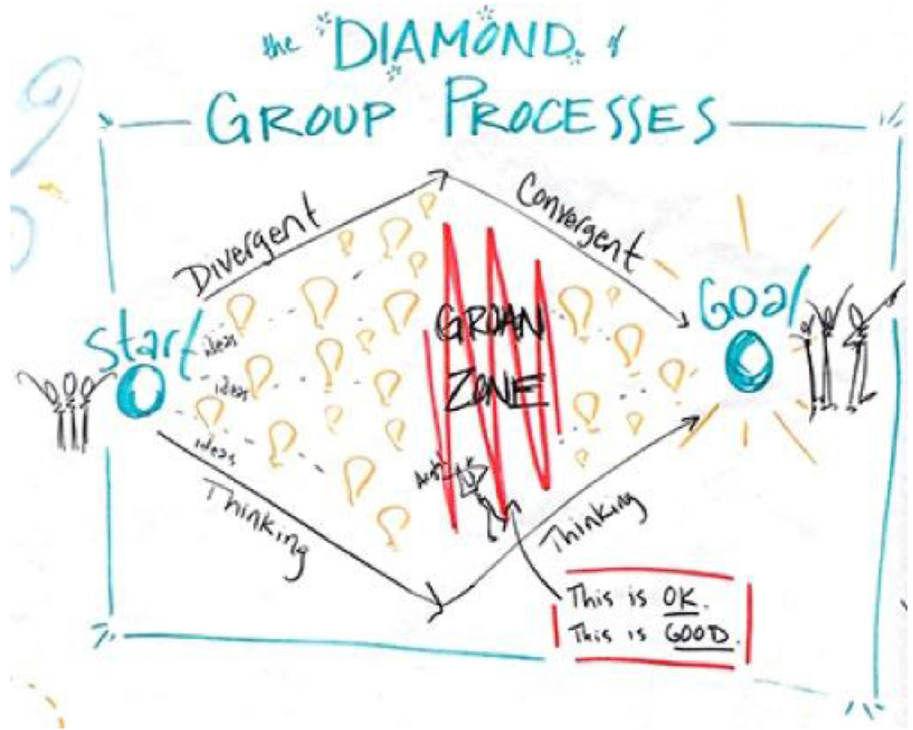
Fig. 1 The ‘‘groan zone’’ depicts the time in a group process when ‘‘divergent’’ thinking (the left side of the diamond where all ideas are heard), shifts into ‘‘convergent’’ thinking (the right side of the diamond where priorities must be identified to winnow the field). The need to drastically reduce the ideas to a realistic few creates the groan zone tension, itself vital for sustainable work and cross- sector understanding (Kaner